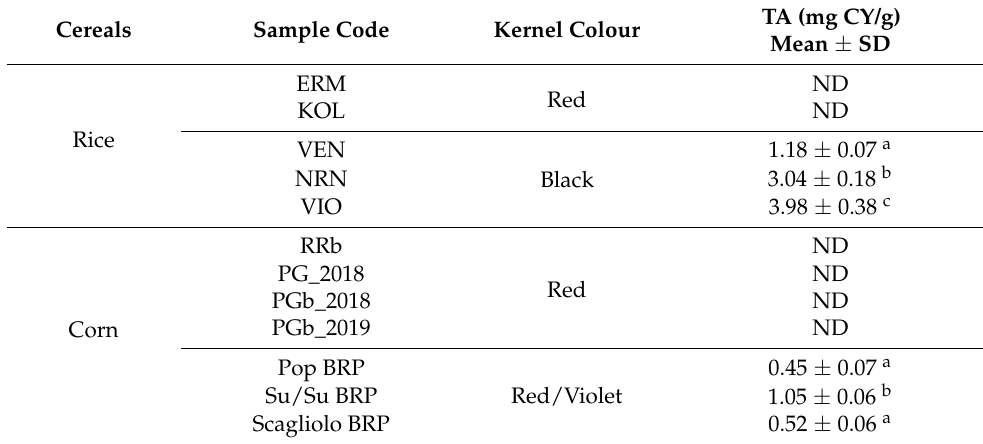
Table 1. Total anthocyanin content (TA) of pigmented rice and corn varieties. Cereals